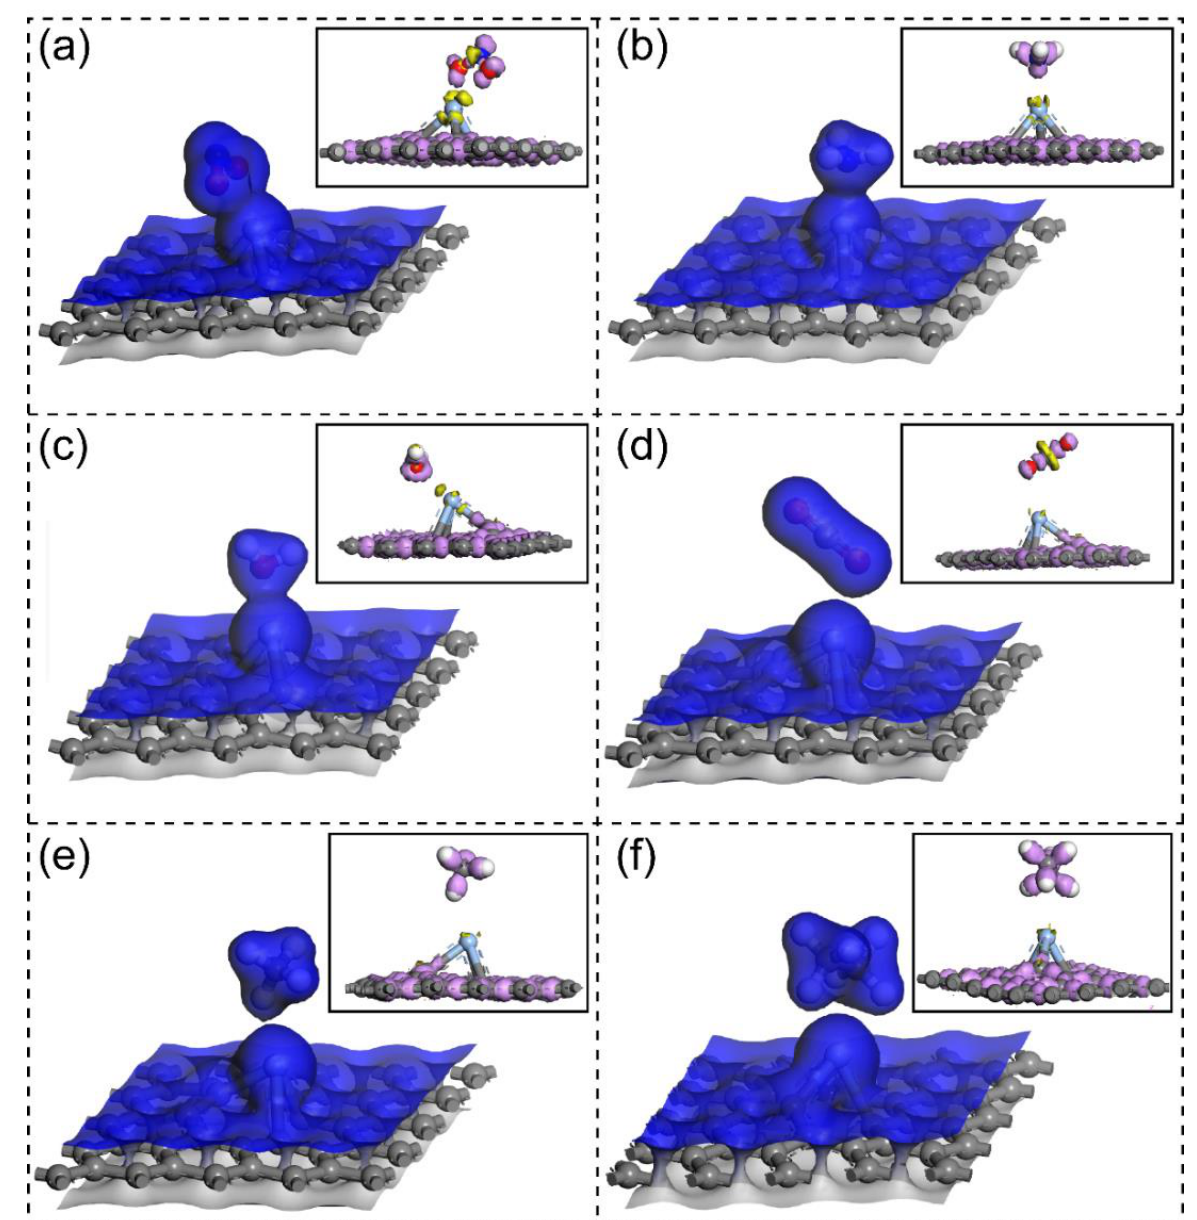
Figure 3. Total charge densities of Ag–Gr adsorption with ( a ) NO 2 , ( b ) NH 3 , ( c ) H 2 O, ( d ) CO 2 , ( e ) CH 4 , and ( f ) C 2 H 6 ; the inserts are the isosurfaces of deformation electron density with isovalues of ± 0.12, where the yellow and pink regions represent electrons loss and accumulation, respectively.